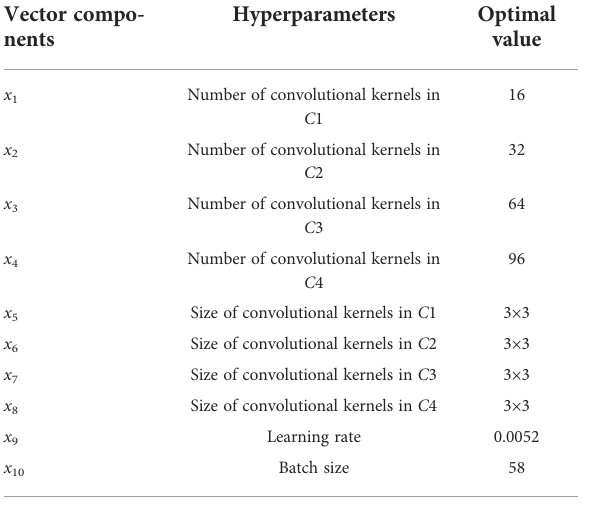
TABLE 6 WOACW_SimpleNet optimal hyperparameters.